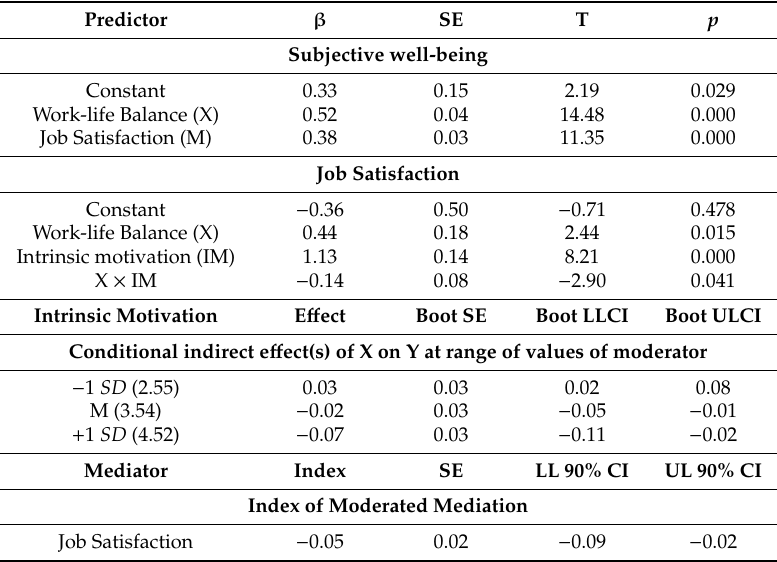
Table 7. Regression Outcomes.